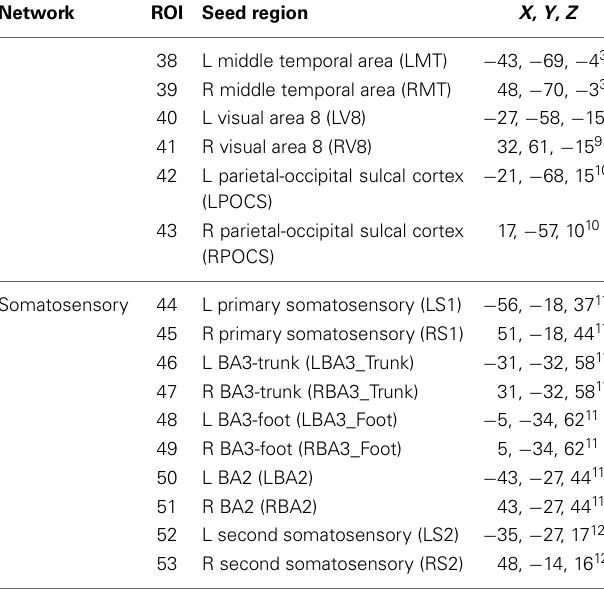
Table 2 | Talairach atlas coordinates for selected seed regions.